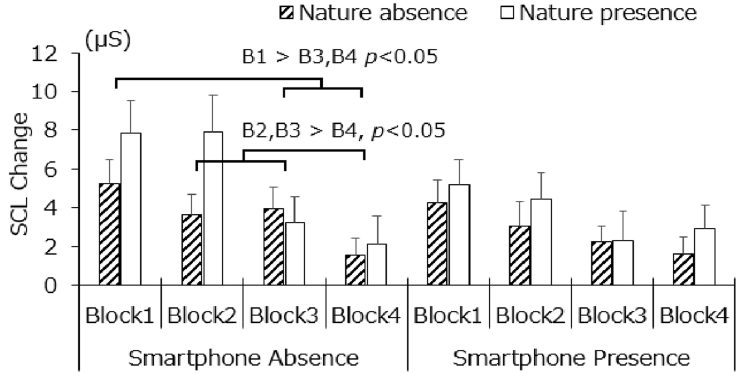
Figure 4. SCL changes. Error bars depict standard error values.